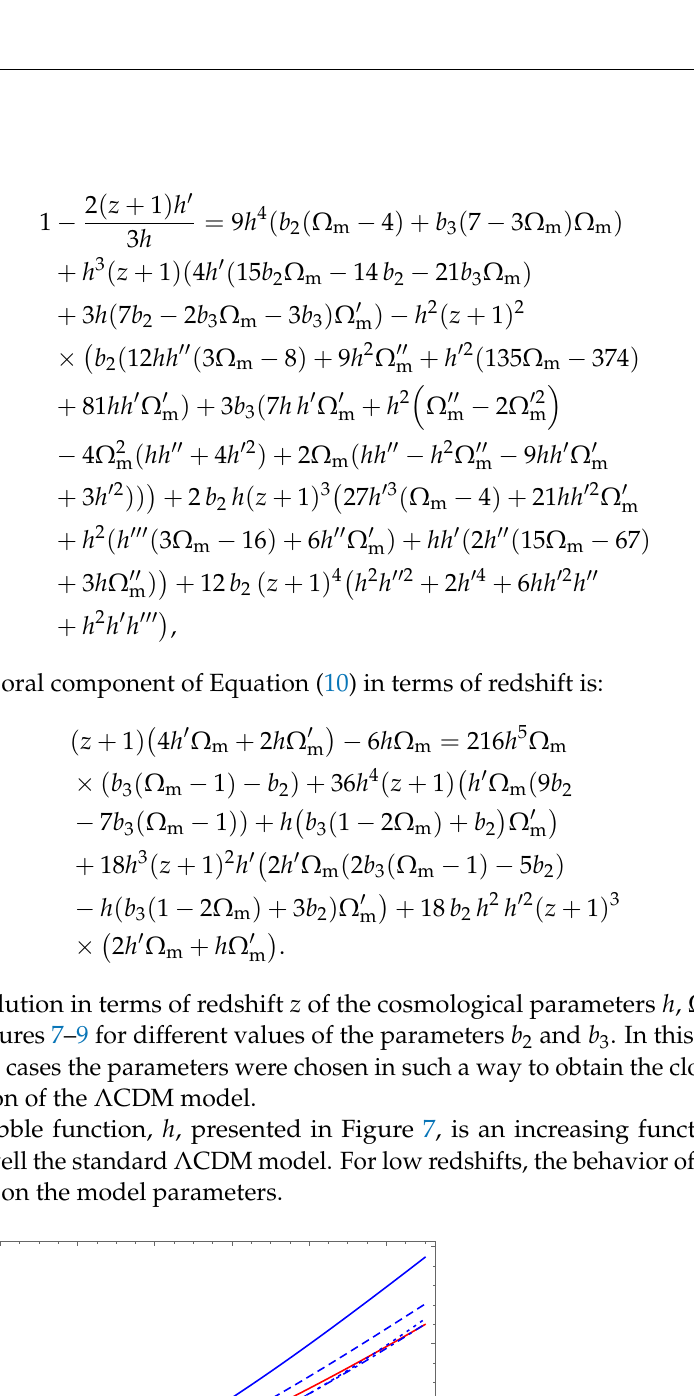
Figure 7. Variation of the Hubble function h as a function of z for K µν = R different values of the parameters b 2 and b 3 : b 2 = − .007 and b 3 = 0.011 (solid curve), b 2 = − 0.08 and b 3 = 0.098 (dotted curve), b 2 = − 0.02 and b 3 = 0.009 (dashed curve), and b 2 = − 0.01 and b 3 = 0.006 (dot-dashed curve). The evolution of the Hubble function in the standard Λ CDM model is described by the red solid